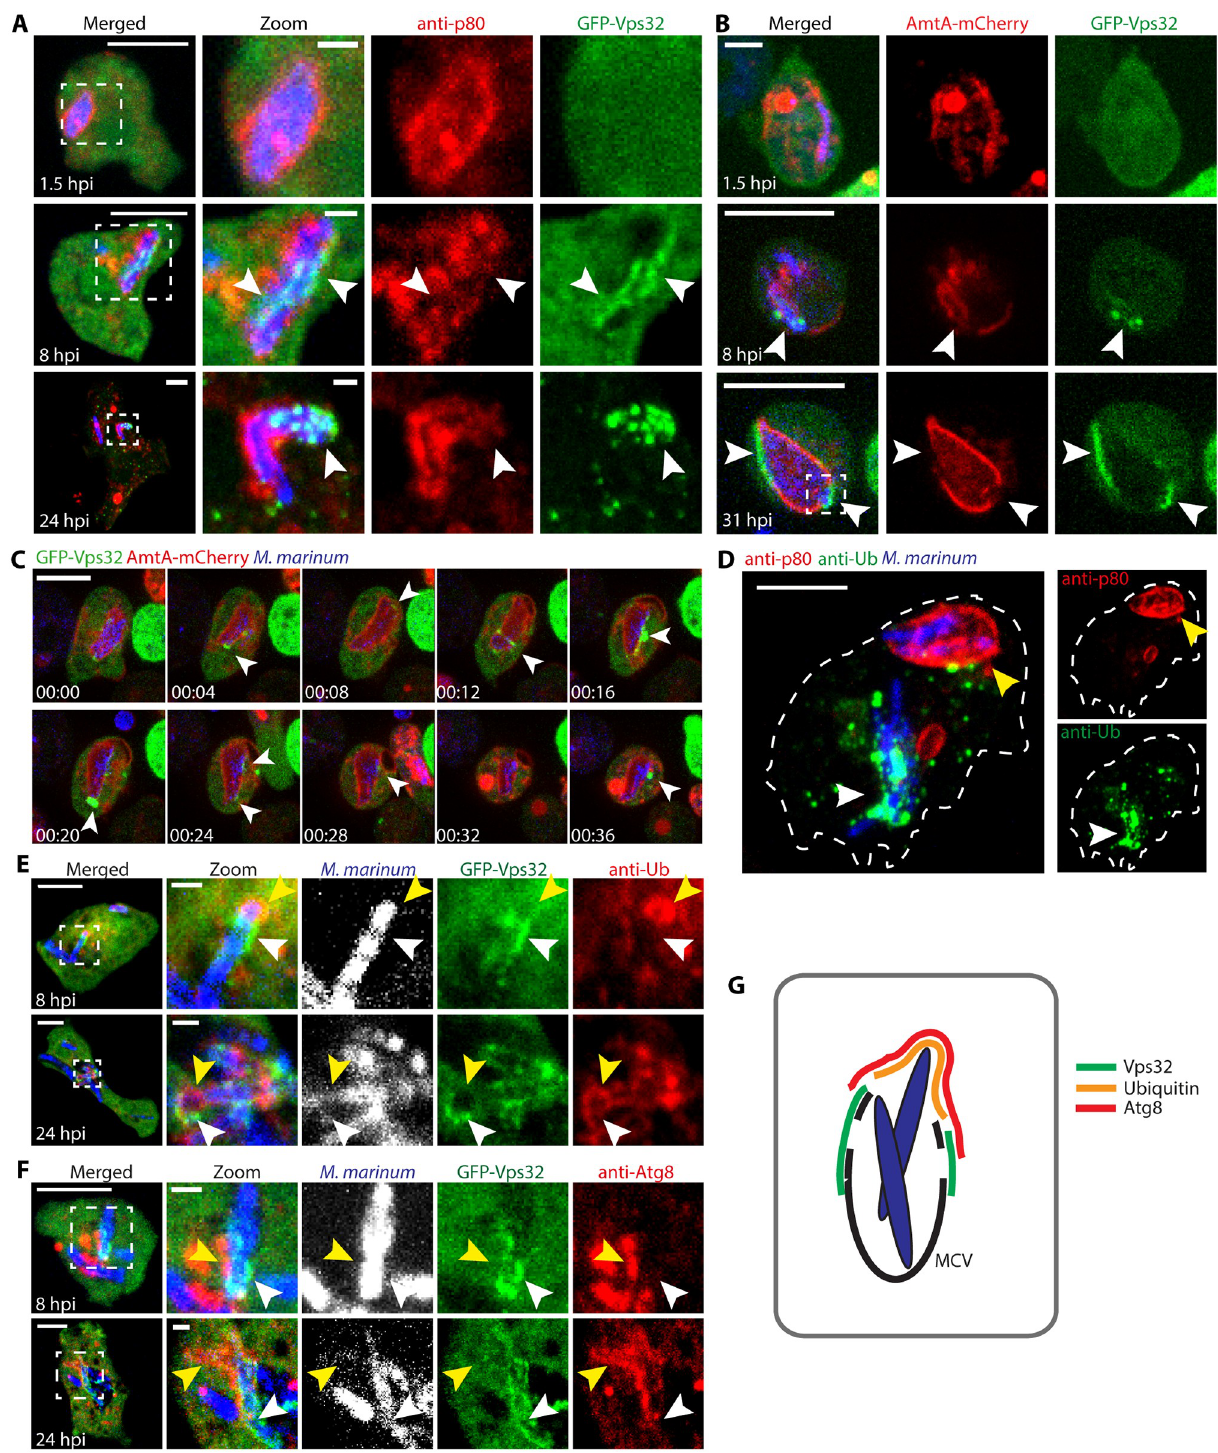
Fig 3. GFP-Vps32 and GFP-Atg8 are recruited to the disrupted MCV at spatially distinct sites. (A) D . discoideum expressing GFP-Vps32 were infected with M . marinum (blue) and fixed for immunostaining against p80 to label the MCV (red). At 1.5 hpi, no GFP-Vps32 structure was visible at apparent intact MCVs. At 8 and 24 hpi, GFP-Vps32 foci and patches appeared in the vicinity of the bacteria, where the MCV was evidently disrupted (arrows). Scale bar, 10 μ m and 1 μ m for the insets. (B-C) D . discoideum expressing GFP-Vps32 and AmtA-mCherry were infected with M . marinum